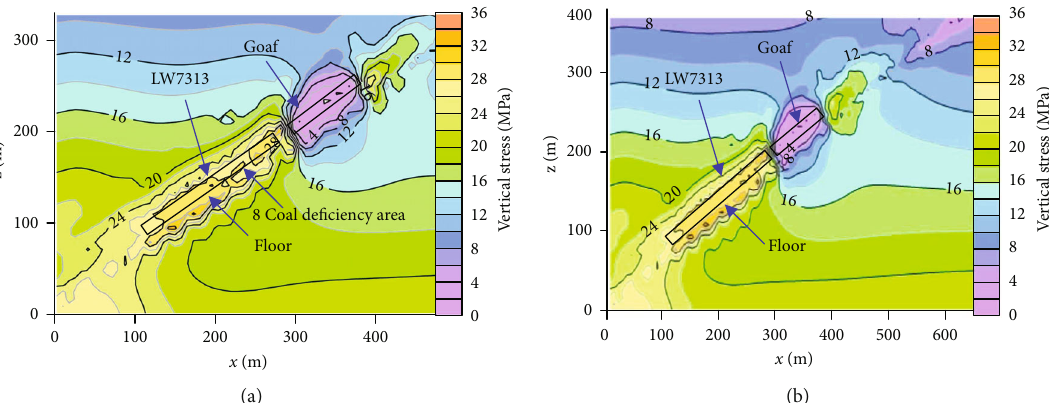
Figure 12: Stress distribution of the inclined section of the working face: (a) scheme ① with No. 8 coal missing area; (b) scheme ② without No. 8 coal missing area.